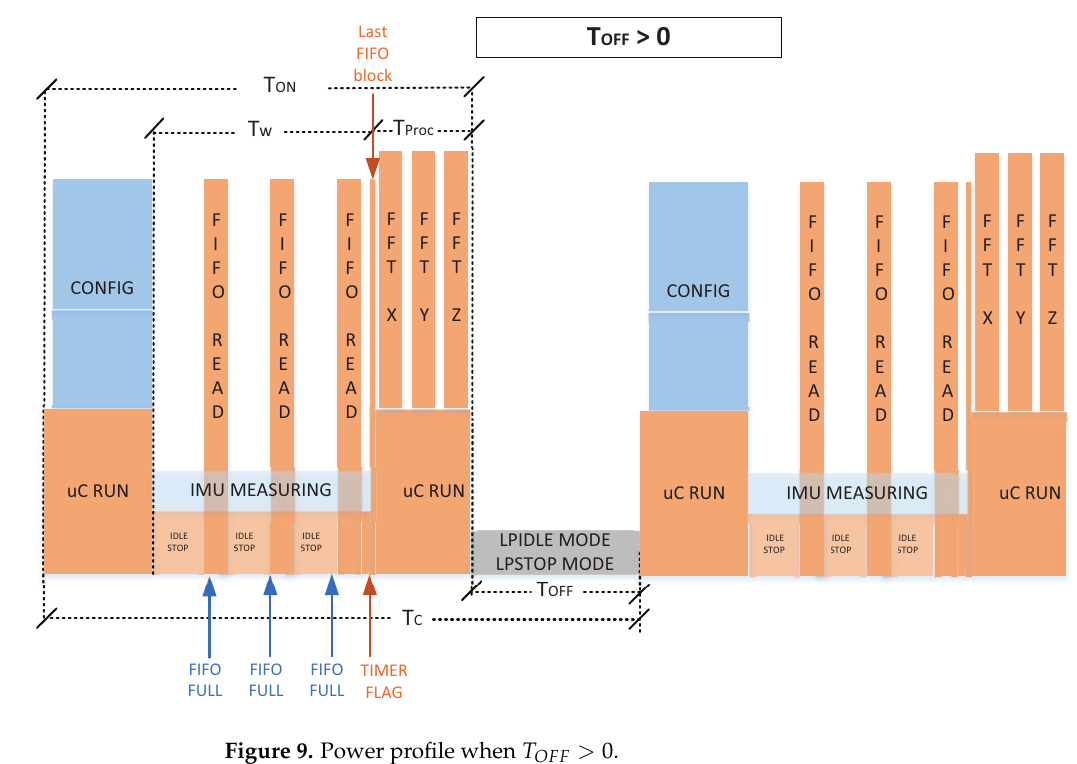
Figure 9. Power profile when T OFF > 0.